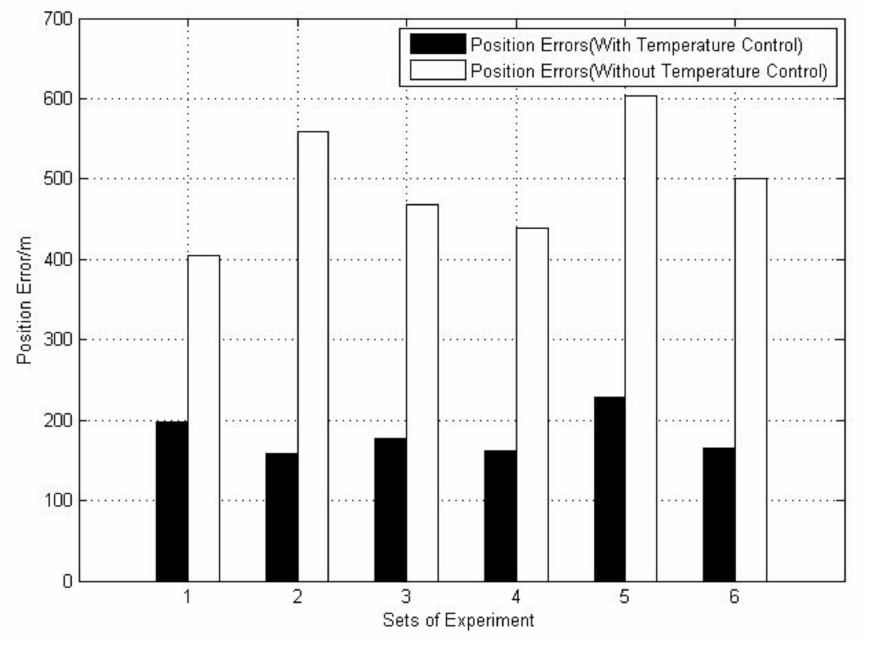
Figure 10. Position errors. Table 8. Position errors of the static